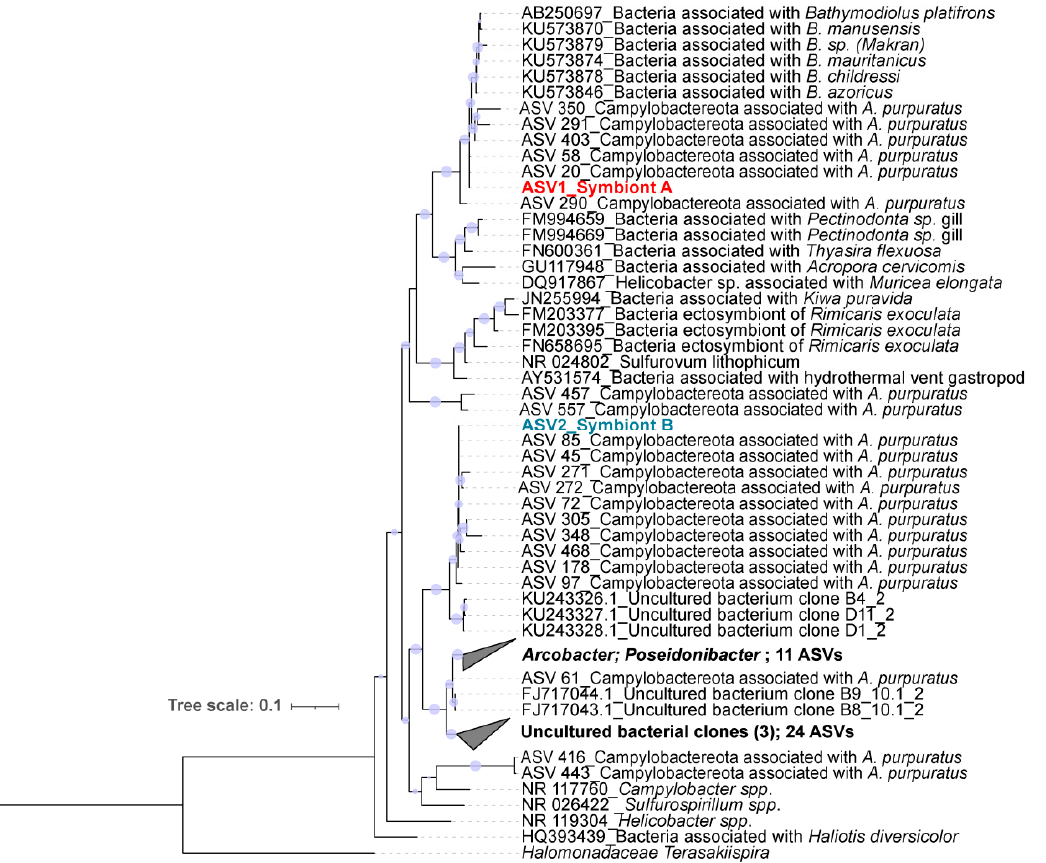
Figure 3. Condensed maximum-likelihood tree reconstruction of Campylobacterota based on the 16S rRNA gene. ML topology shown with SH-like approximate likelihood ratio support values ( n = 1000) given at each node (values >50% are shown). Halomonadaceae terasakiispira was used as root for the tree. The scale bar represents 10% estimated sequence divergence per nucleotide position.